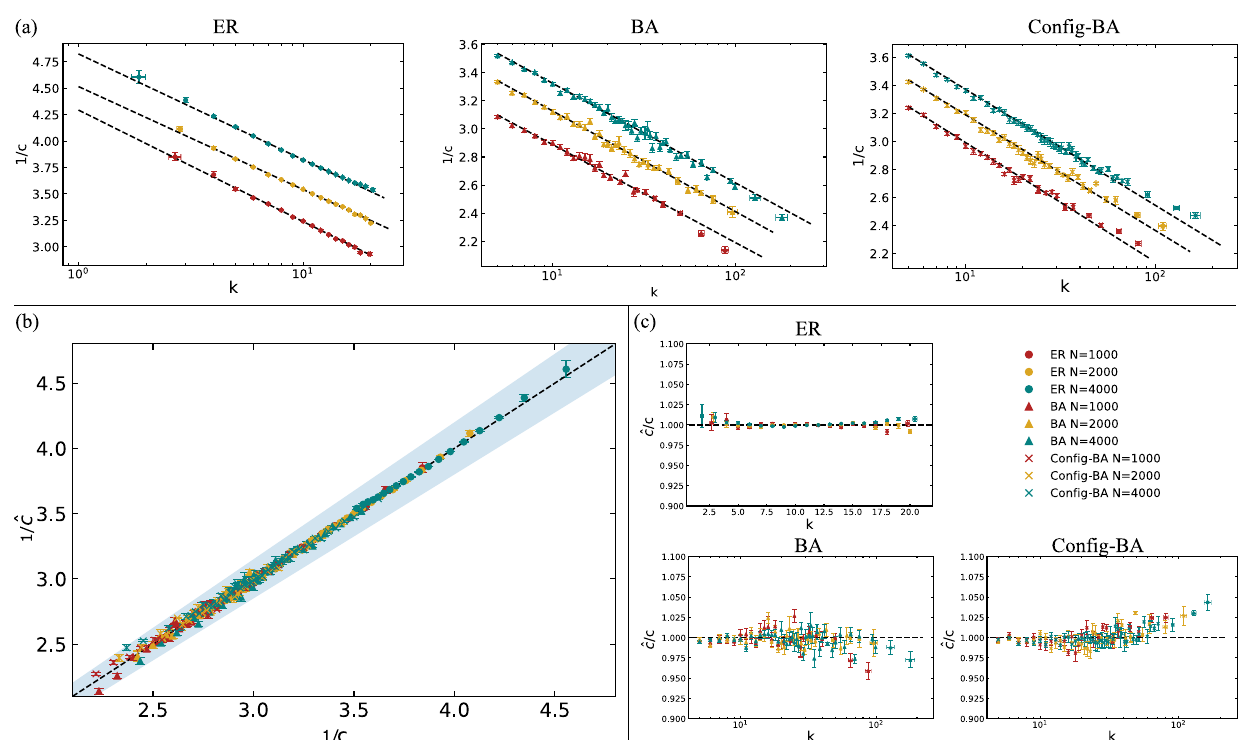
Fig. 2 Closeness and degree for arti fi cial networks. In ( a ), each plot shows results for networks formed from one arti fi cial model: the Erd ő s-Réyni (ER) model, the Barabási-Albert (BA) model, and the con fi guration model network starting from a Barabási-Albert model (Con fi g-BA). The dashed lines shows the best linear fi t of 1/ c to ln ð k Þ using Eq. (5). The same data from all nine arti fi cial networks is shown in the scatter plot in ( b ) with data 1 = ^ c against predicted value c obtained from the best fi t Eq. (5) and the shaded region corresponds to a 5% deviation from the theoretical prediction. Panel c shows the fractional error, the fi tted value of closeness divided by data value. The results are for three different sized networks: N = 1000 (red points) N = 2000 (blue points) and N = 4000 (yellow points) where N is the number of nodes. All networks have average degree 10.0 and 100 realisations were taken for each case. The values of closeness for each value of degree are binned, the mean is shown as the data point with error bars the standard error of the mean. The results show that the non-linear correlation of closeness and degree predicted in Eq. (5) works most of the time within a 2% variation. There are some hints of small but systematic at higher degree value but the data are sparse and less reliable